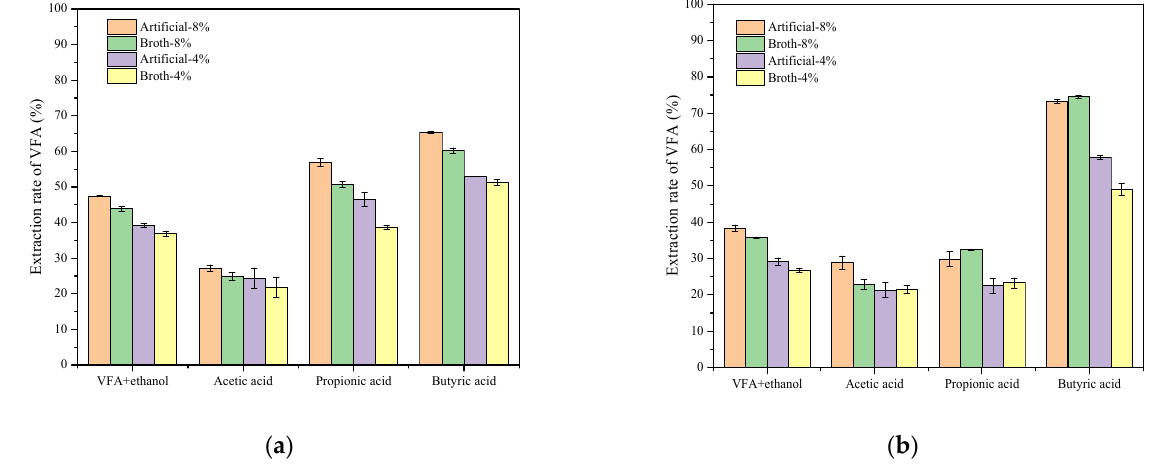
Figure 4. Extraction rates of VFA from different type fermentation broth and artificial solution (( a ) butyric acid type; ( b ) mixture acid type).